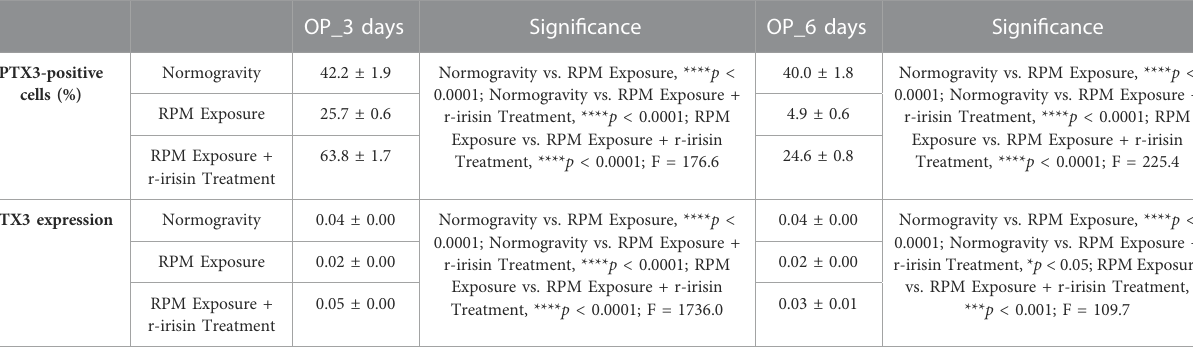
TABLE 5 Mean values ± standard error and relative signi fi cance for the mineralization process assessment in OP patients after 3 and 6 days of RPM